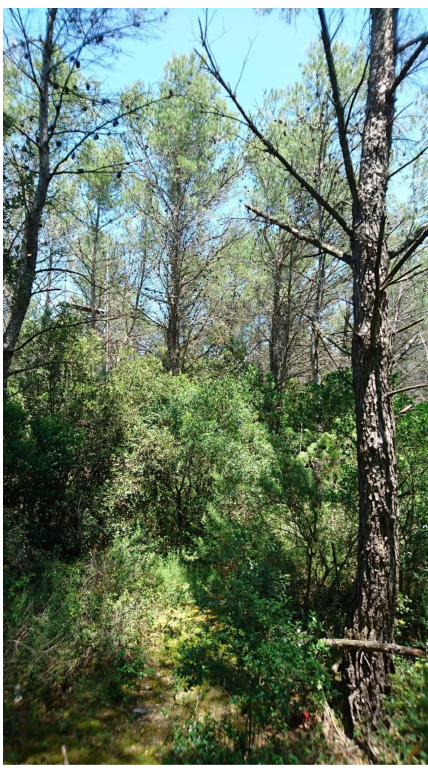
Figure 7. Foliage stratification between overstory and understory bushes at the ICOS site of Font Blanche in southeastern France. Please note that the understory in situ measurements reported in Fig. 6 did not include the tall ( h> 2m) bushes located under the Pinus-halepensis -dominated